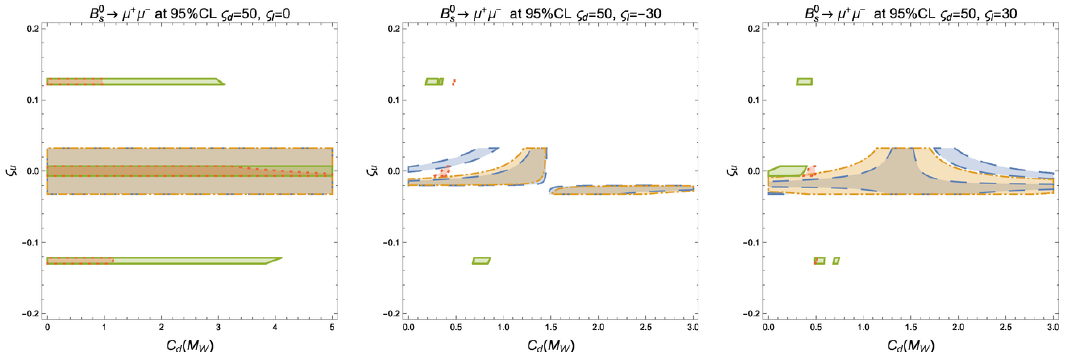
Figure 5. B 0 ! (cid:22) + (cid:22) (cid:0) constraints (95% CL) on C d ( M W ) and & u , in the CP-conserving limit, for s (cid:21) 3 = (cid:21) 7 = 1, c ~ (cid:11) = 0 : 95 and & d = 50, with & l = 0 (left), & l = (cid:0) 30 (middle) and & l = +30 (right) . Same colour coding than (cid:12)gure